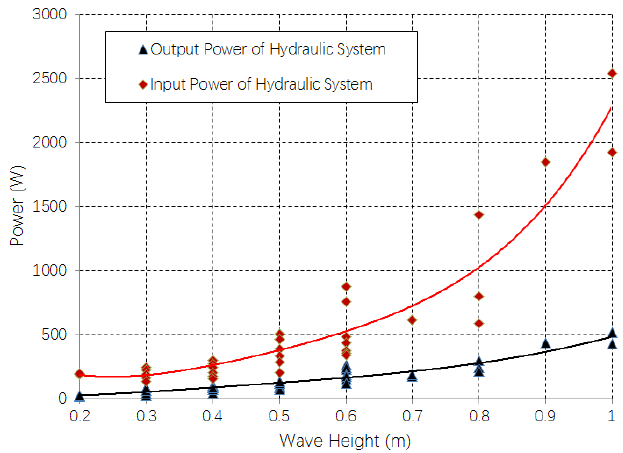
Figure 4. Comparison of the input and output power of the hydraulic system.